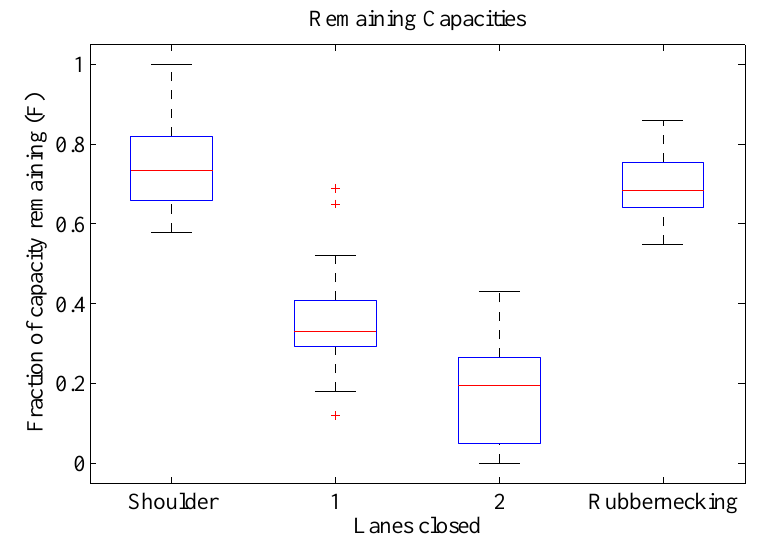
Figure 5. The capacity factors found for different